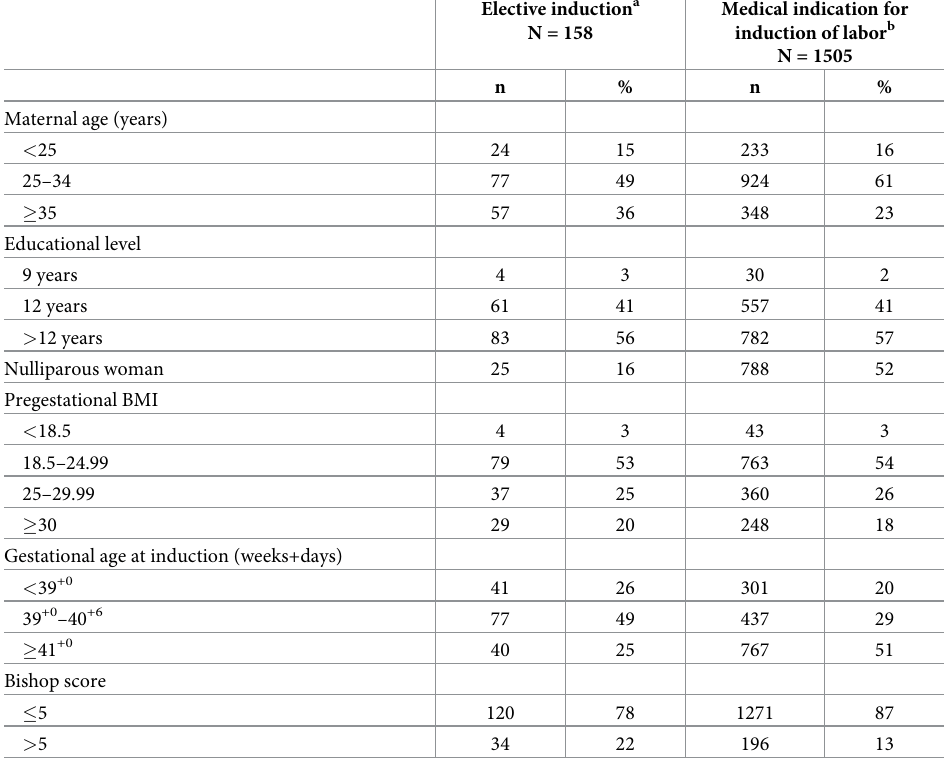
Table 1. Characteristics of the